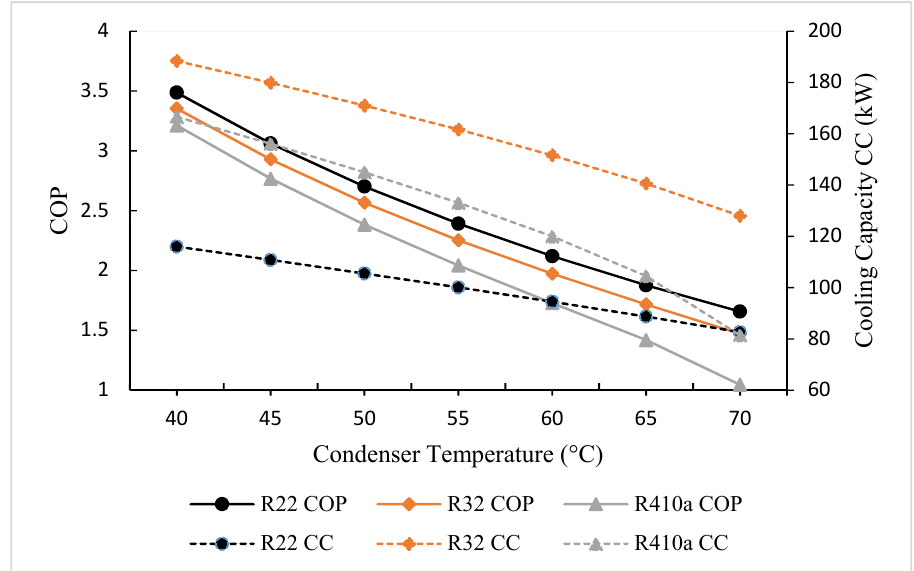
Figure 7. Variation of COP and cooling capacity versus condenser temperature at constant evaporative temperature − 10 ℃ .